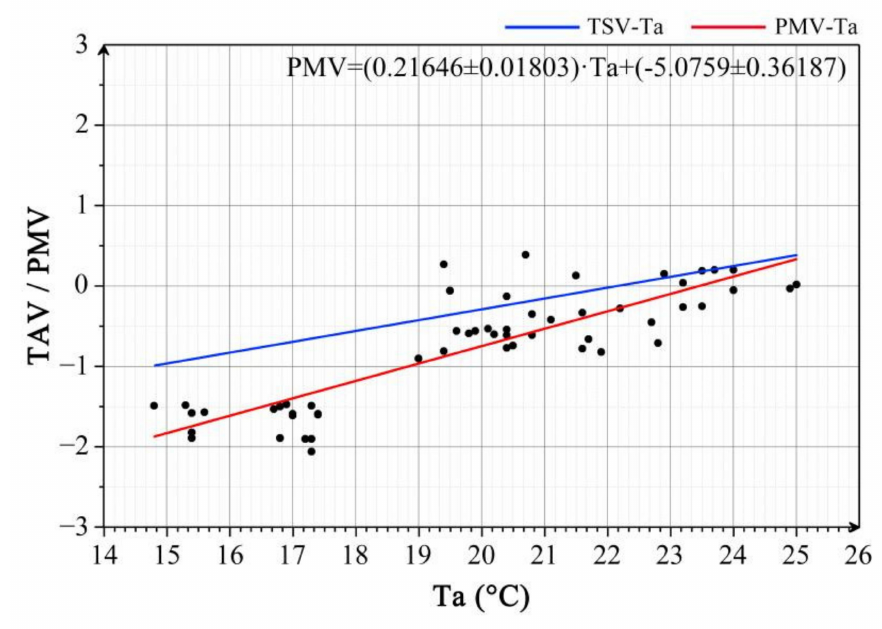
Figure 14. The quantitative relationship between PMV and